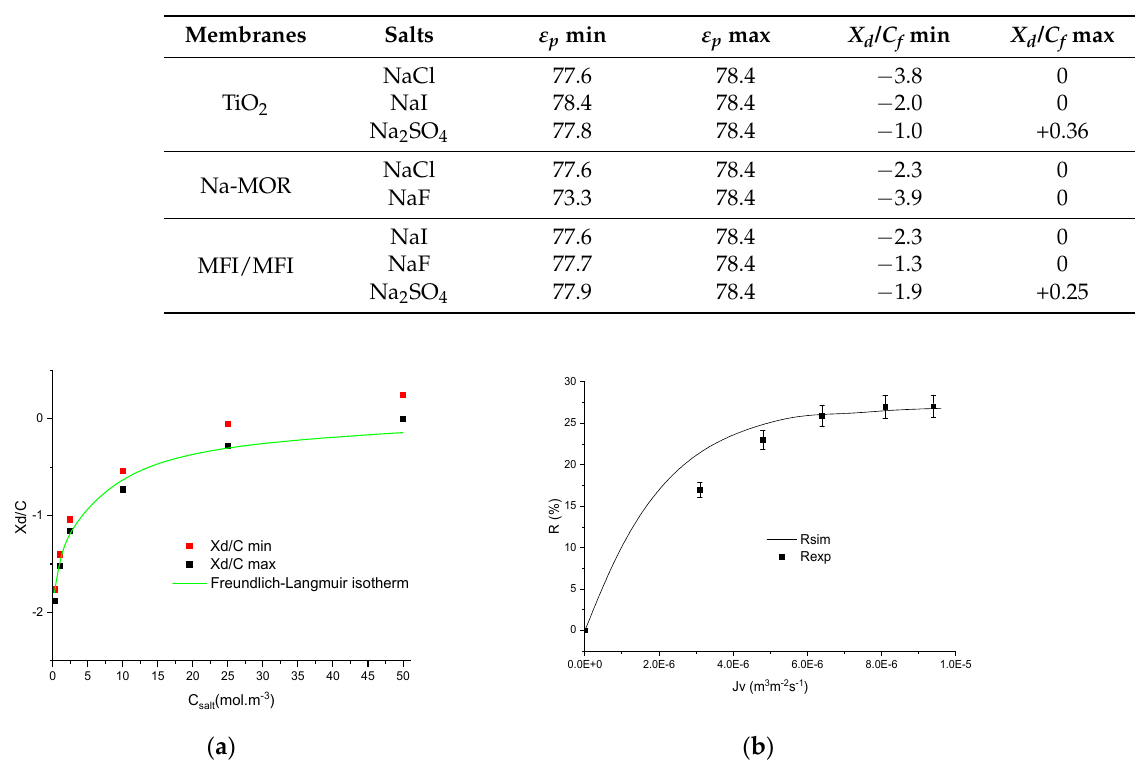
Figure 4. ( a ) Evolution of minimum and maximum normalised volumetric charge density with concentration and ( b ) rejection curve obtained experimentally and simulated from the corresponding best-fitted Langmuir–Freundlich isotherms obtained by filtration of Na 2 SO 4 0.44 mol m − 3 by the MFI–MFI membrane.